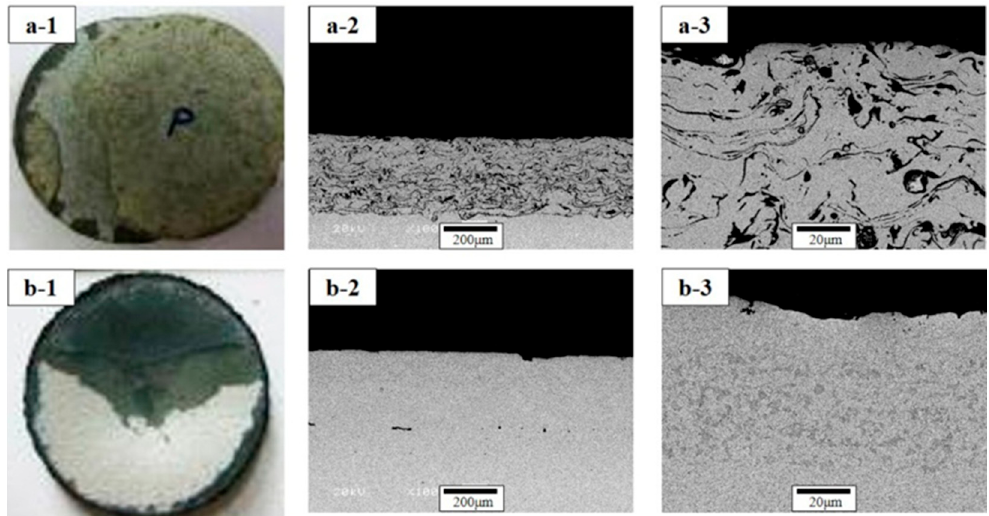
Figure 5. Surface micrographs and cross-sectional microstructures of TBCs after TS tests: TBC with APS bond coat (the surface micrographs ( a–1 ), cross-sectional ( a–2 ) and magnified interface ( a–3 ) microstructures) and TBC with HVOF bond coat (the surface micrographs ( a–1 ), cross-sectional ( a–2 ) and magnified interface ( a–3 )